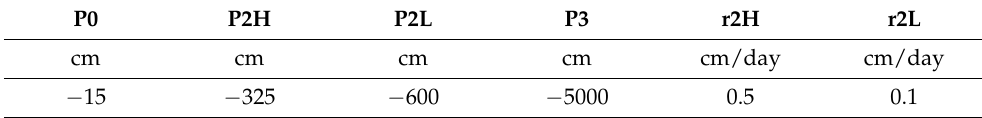
Table 3. Root water uptake